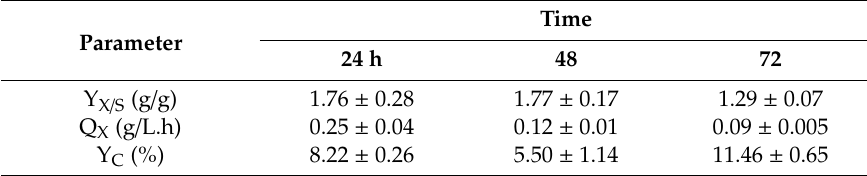
Table 2. Kinetic parameters of cell biomass yield (Y X / S ), volumetric cell productivity (QX), and